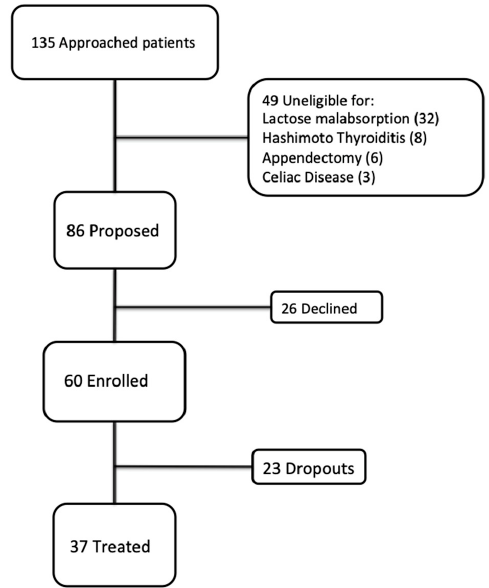
Figure 1. Study flow chart.